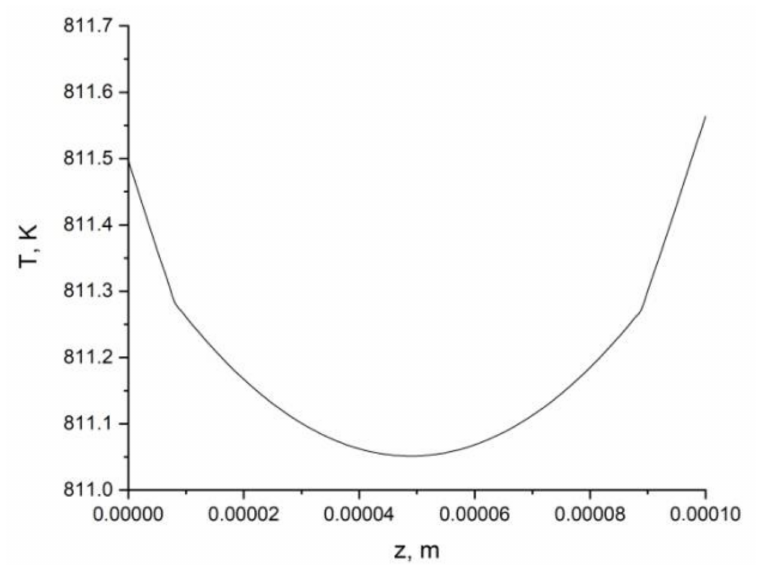
Figure 4. Temperature distribution over the thickness of a birch leaf under the influence of a low- intensity surface forest fire at time t = 3 s (summer, July, +20 ◦ C, ϕ 30 =